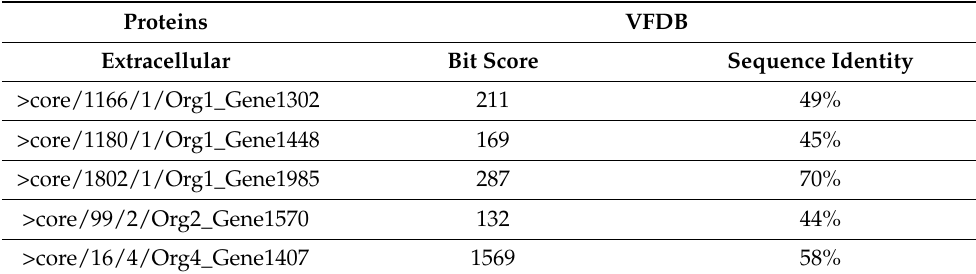
Table 3. List of virulent proteins.